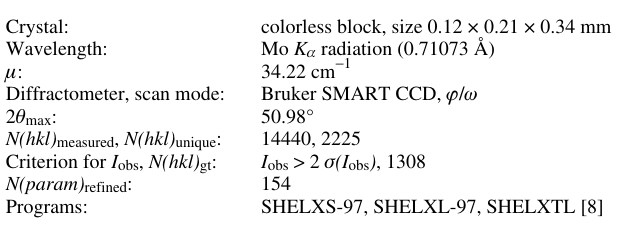
Table 1. Data collection and handling.